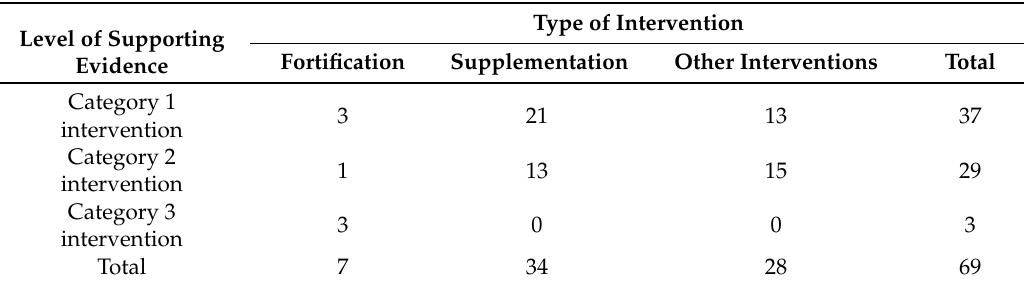
Table 2. Number of nutrition interventions in the e-Library of Evidence for Nutrition Actions (eLENA) addressing micronutrient deficiencies, by type of intervention and level of supporting